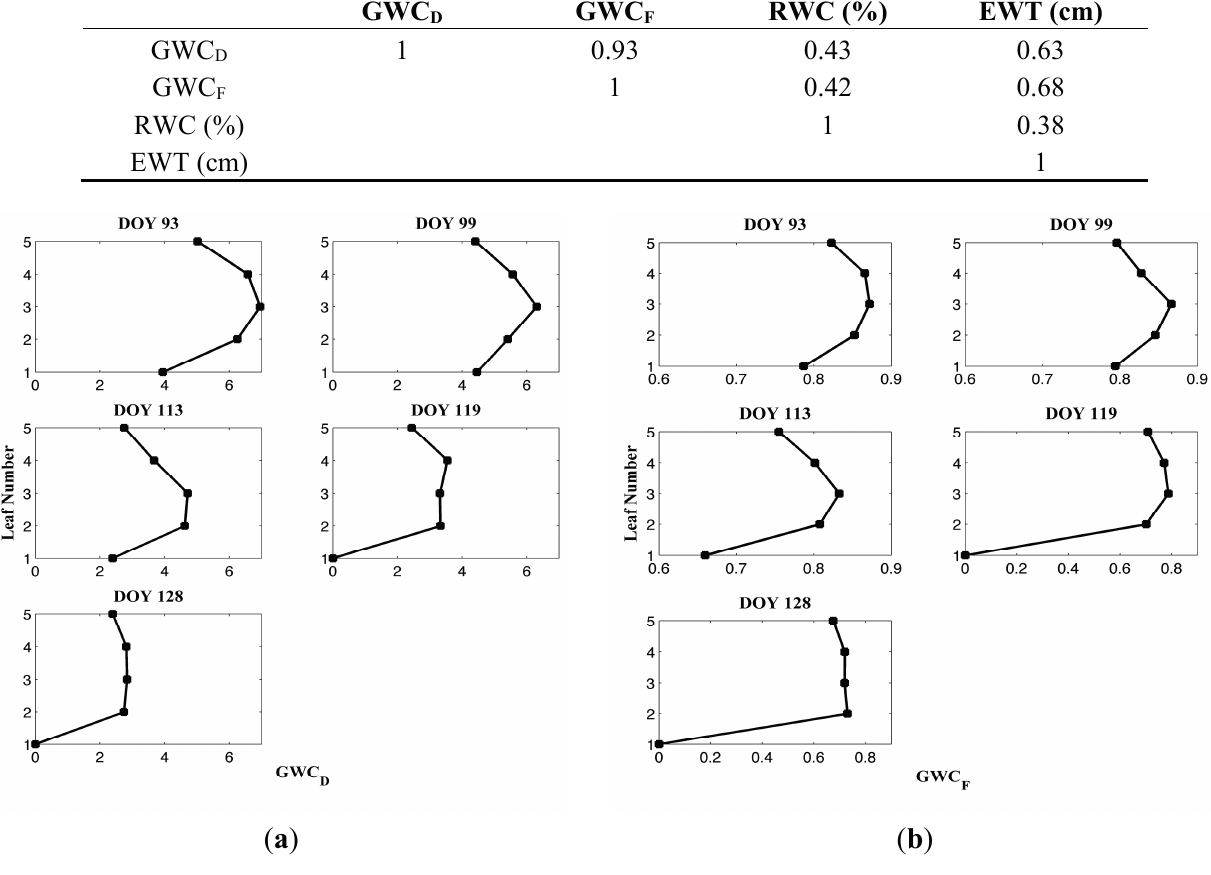
Table 4. Correlation coefficients ( r ) among water-related properties at leaf level.